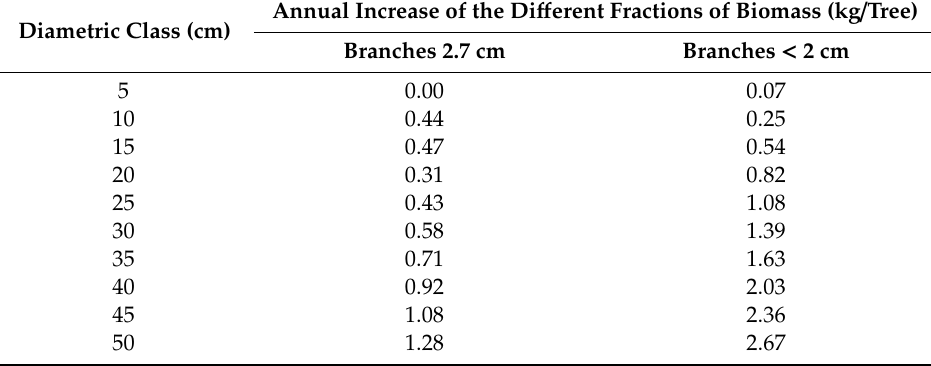
Table 3. Annual increases of biomass per species and diametric class (kg / tree).